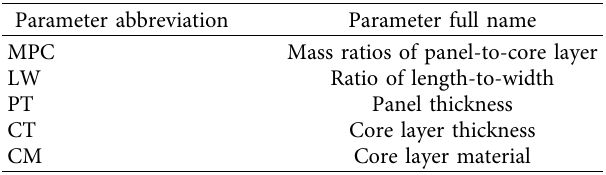
Table 5: Legend description.